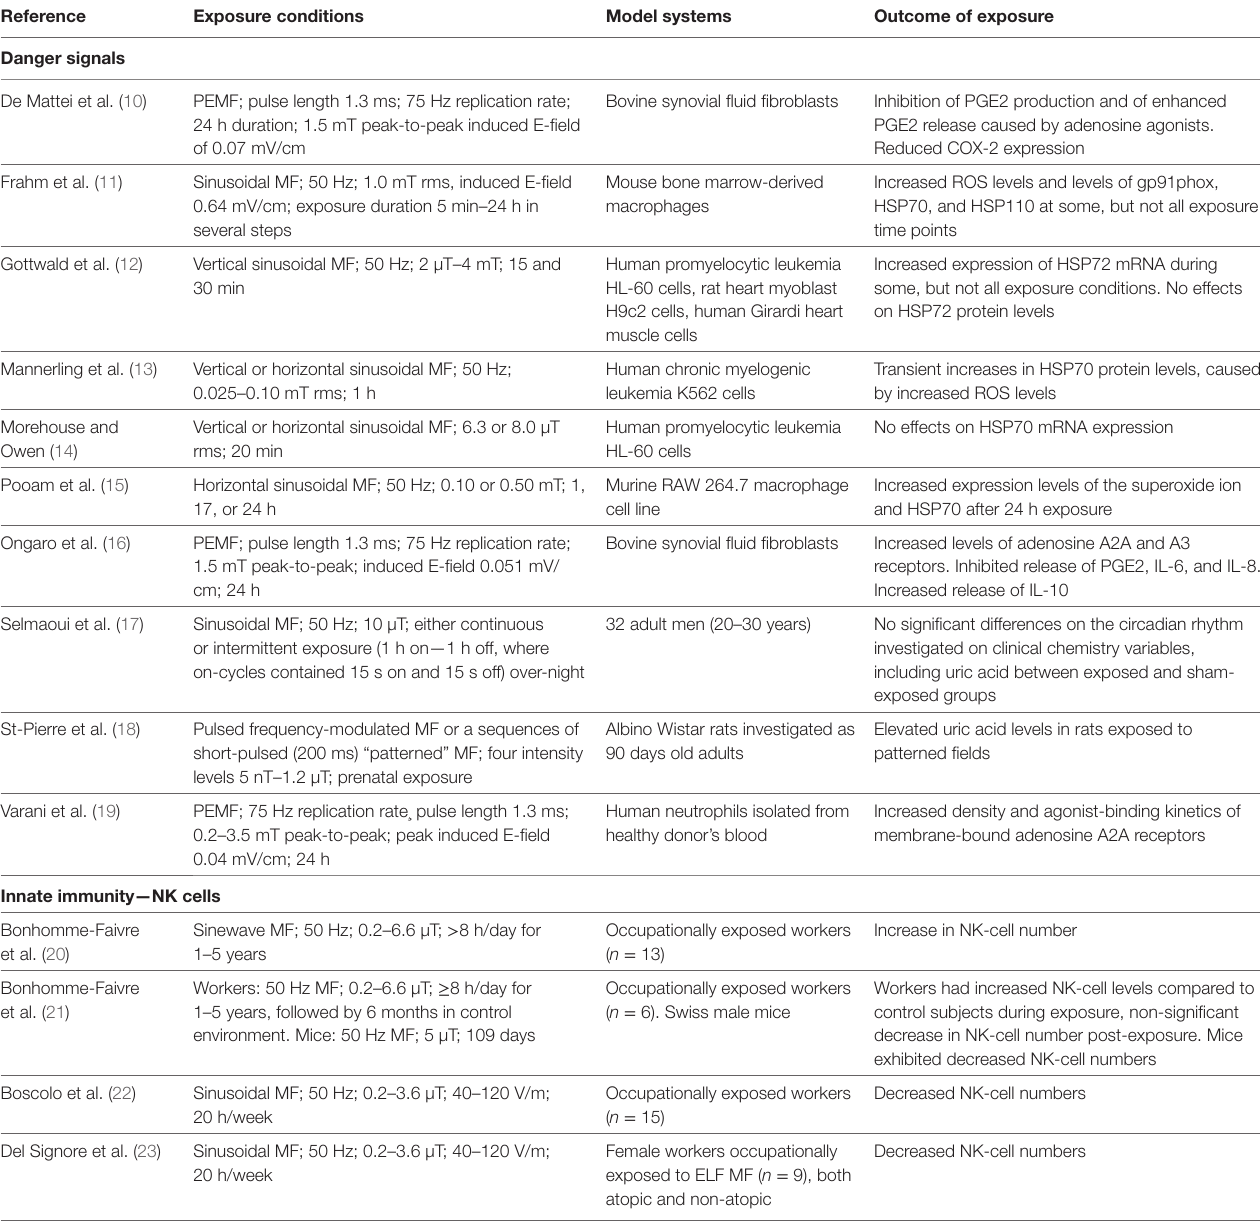
TabLe 1 | Available study details in papers cited in sections on danger signals, innate immunity and wound healing, that are dealing with experimental effects of MF